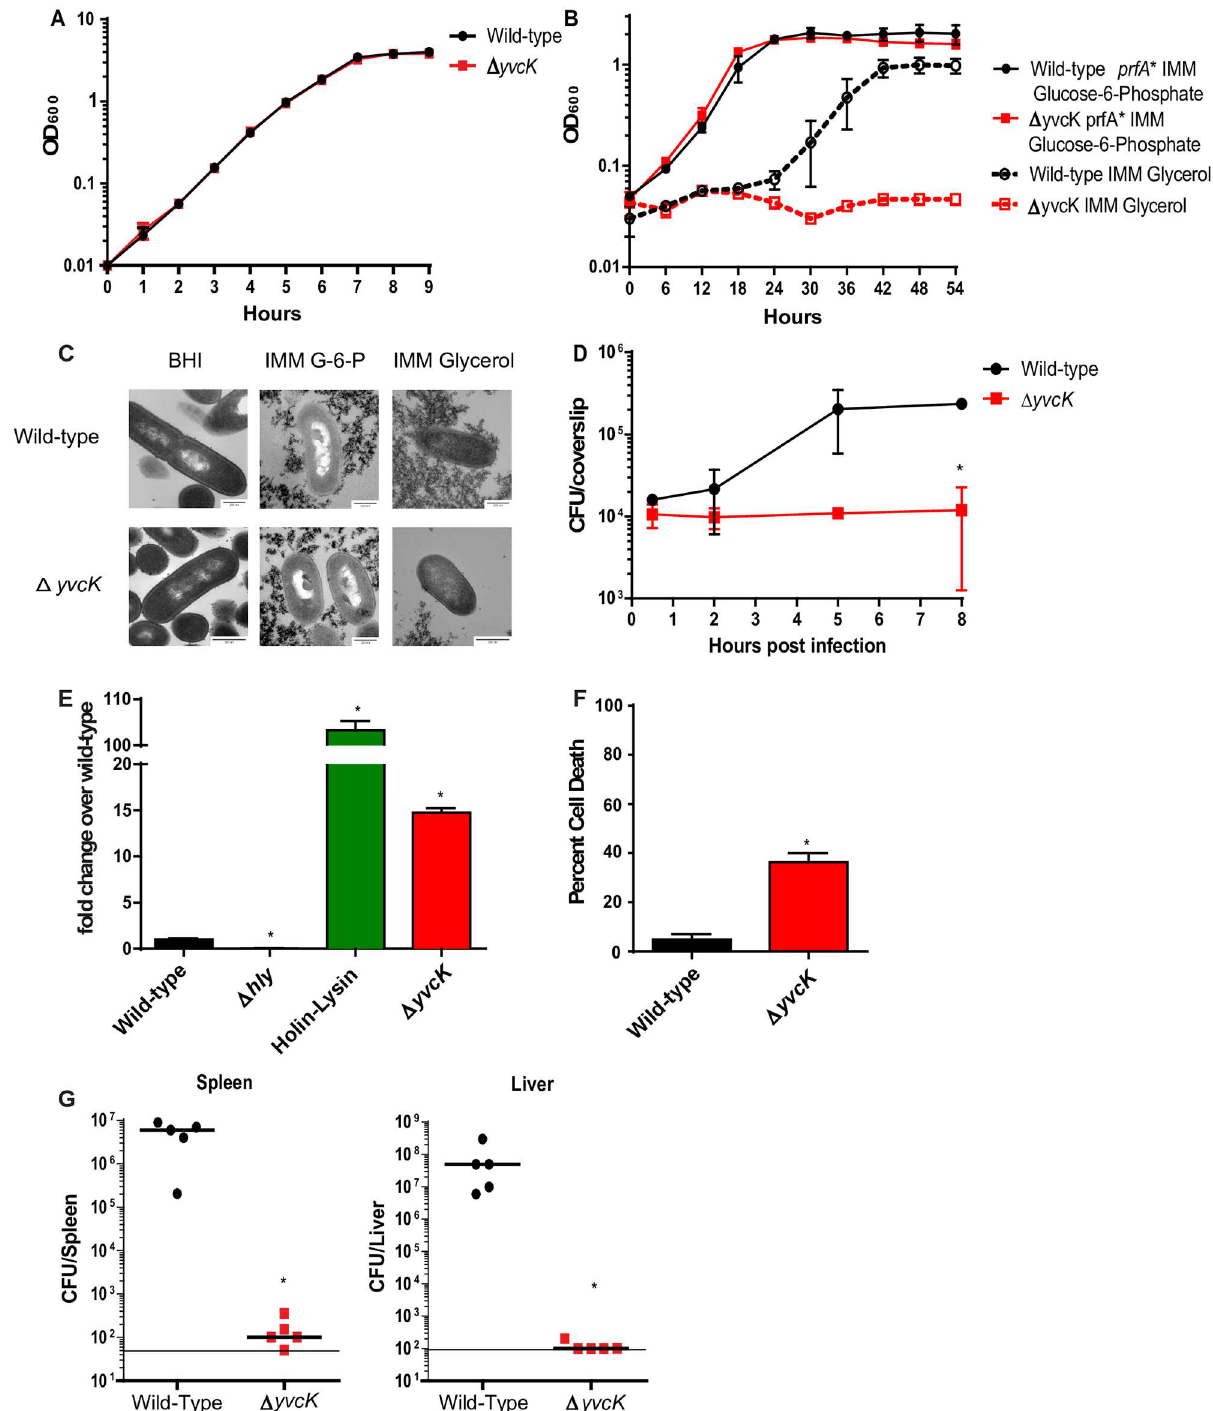
Fig 3. Δ yvcK mutants phenocopy Δ prkA mutants in vitro , ex vivo and in vivo . (A ) Growth of the Δ yvcK mutant in BHI, (B) or in IMM with glucose-6-phosphate (filled symbols and solid lines) or glycerol (open symbols and dashedlines) as the sole carbon source. Data are averages of three biologicalreplicates and error bars represent standard deviationof the mean. (C) Morphology of wild-type and the Δ yvcK mutant in BHI, IMM Glucose-6-phosphate, and IMM Glycerol at OD 0.5 (BHI) or 6 hours post inoculation. (D) Intracellular growth of wild- type (black circles) and Δ yvcK mutants (red squares) was determined in bone marrow-derived macrophages (BMDMs) followinginfection at an MOI of 0.2. (E) Intracellular lysis of L . monocytogenes was measured in immortalizedIFNAR -/- macrophages. Macrophages were